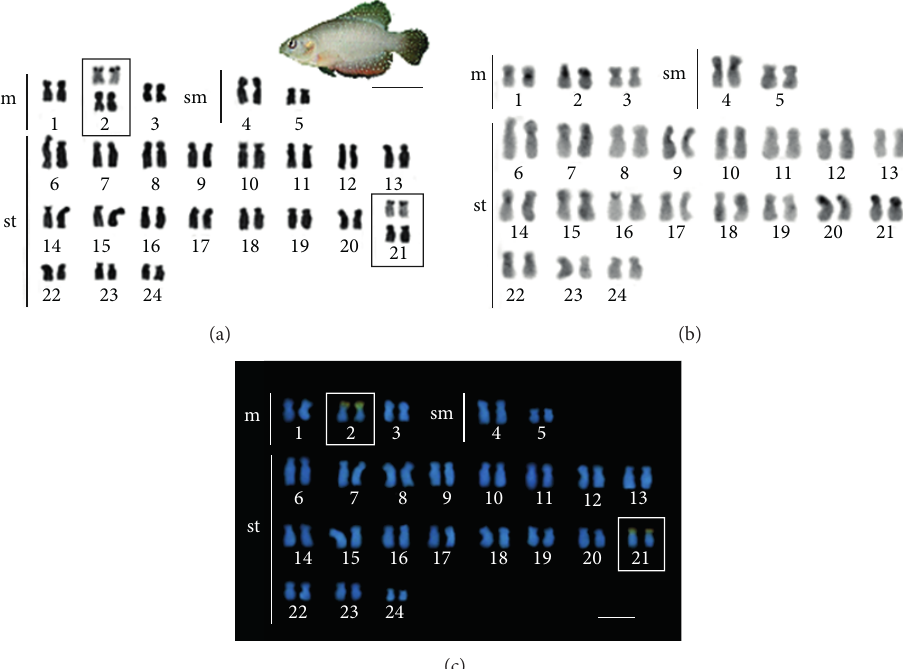
Figure 2: Karyotype and a male of Hypsolebias antenori (Bar = 1cm): (a) stained with Giemsa; (b) C-banding, and (c) sequential staining with fluorochromes CMA 3 and DAPI. Ag-NORs sites are shown highlighted in box (bar = 5 𝜇